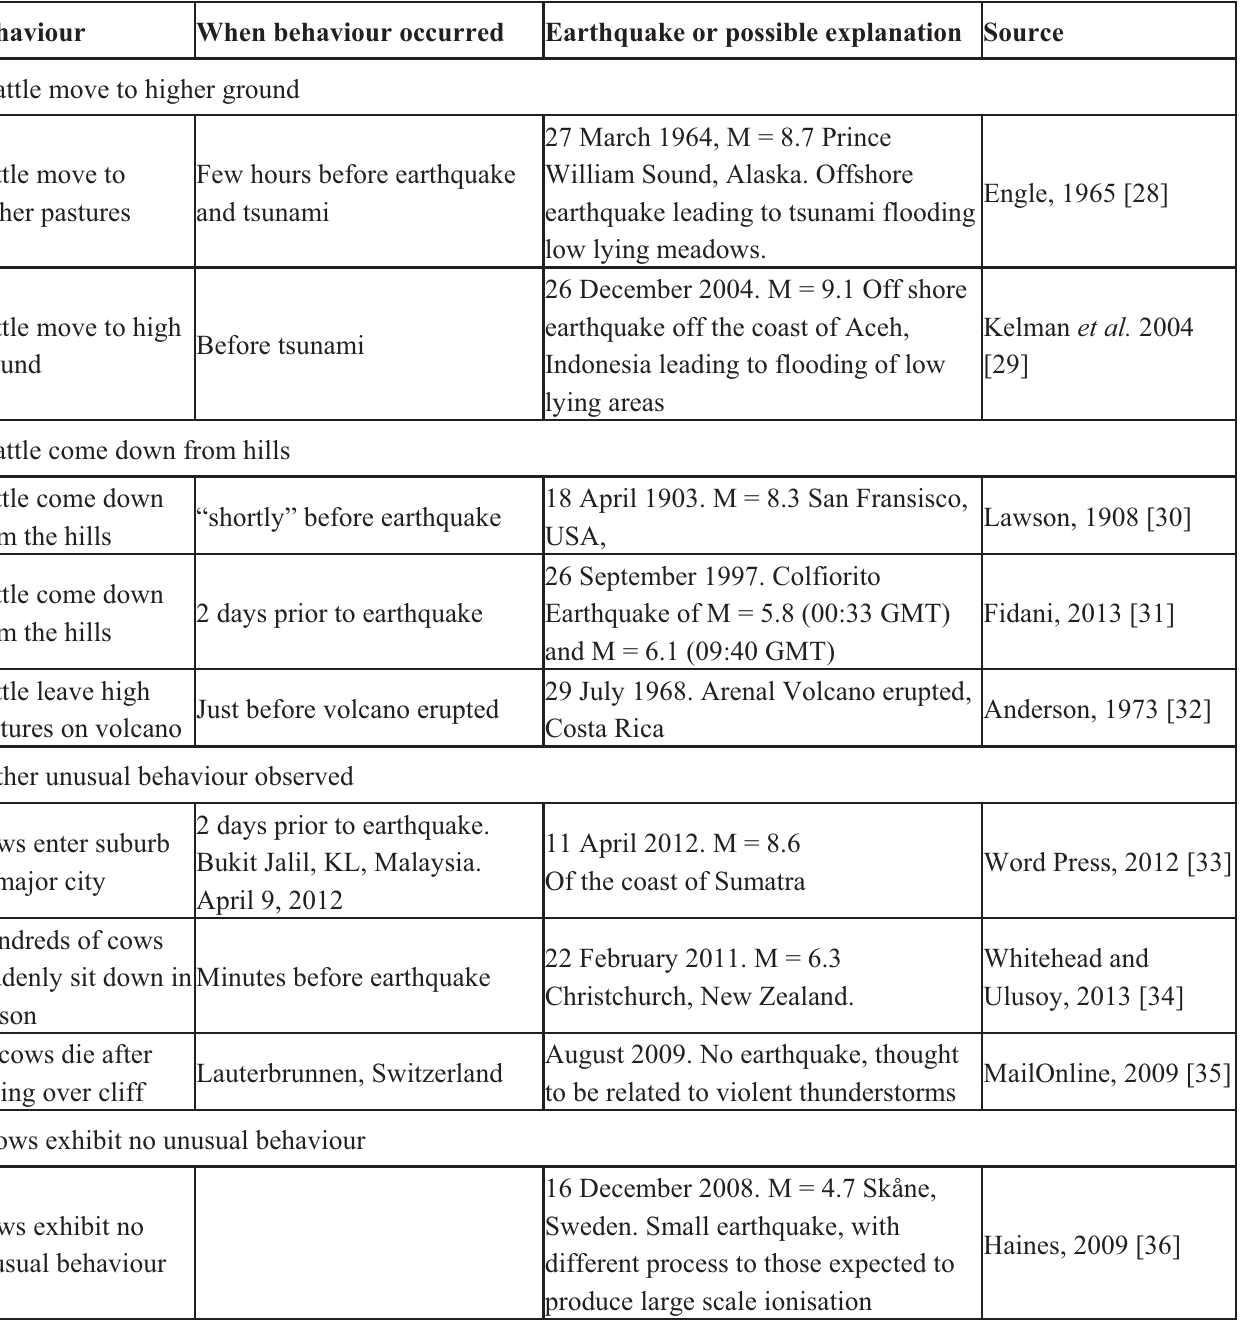
Table 1. A summary of reports of unusual behaviour in free ranging